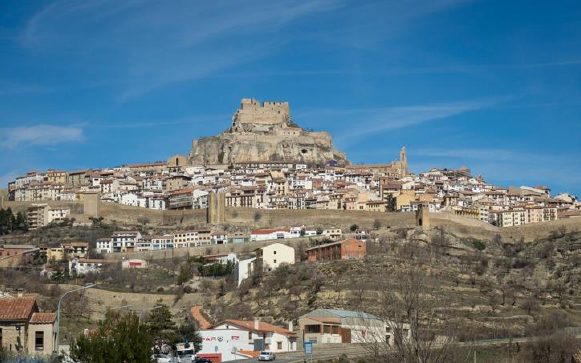
Figure 1. View of the town of Morella (Source: S. Portela,